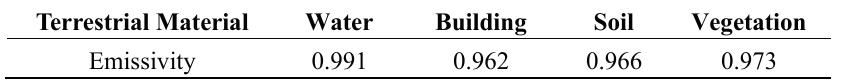
Table 8. Emissivity of representative terrestrial materials for the Landsat 8 TIRS Band